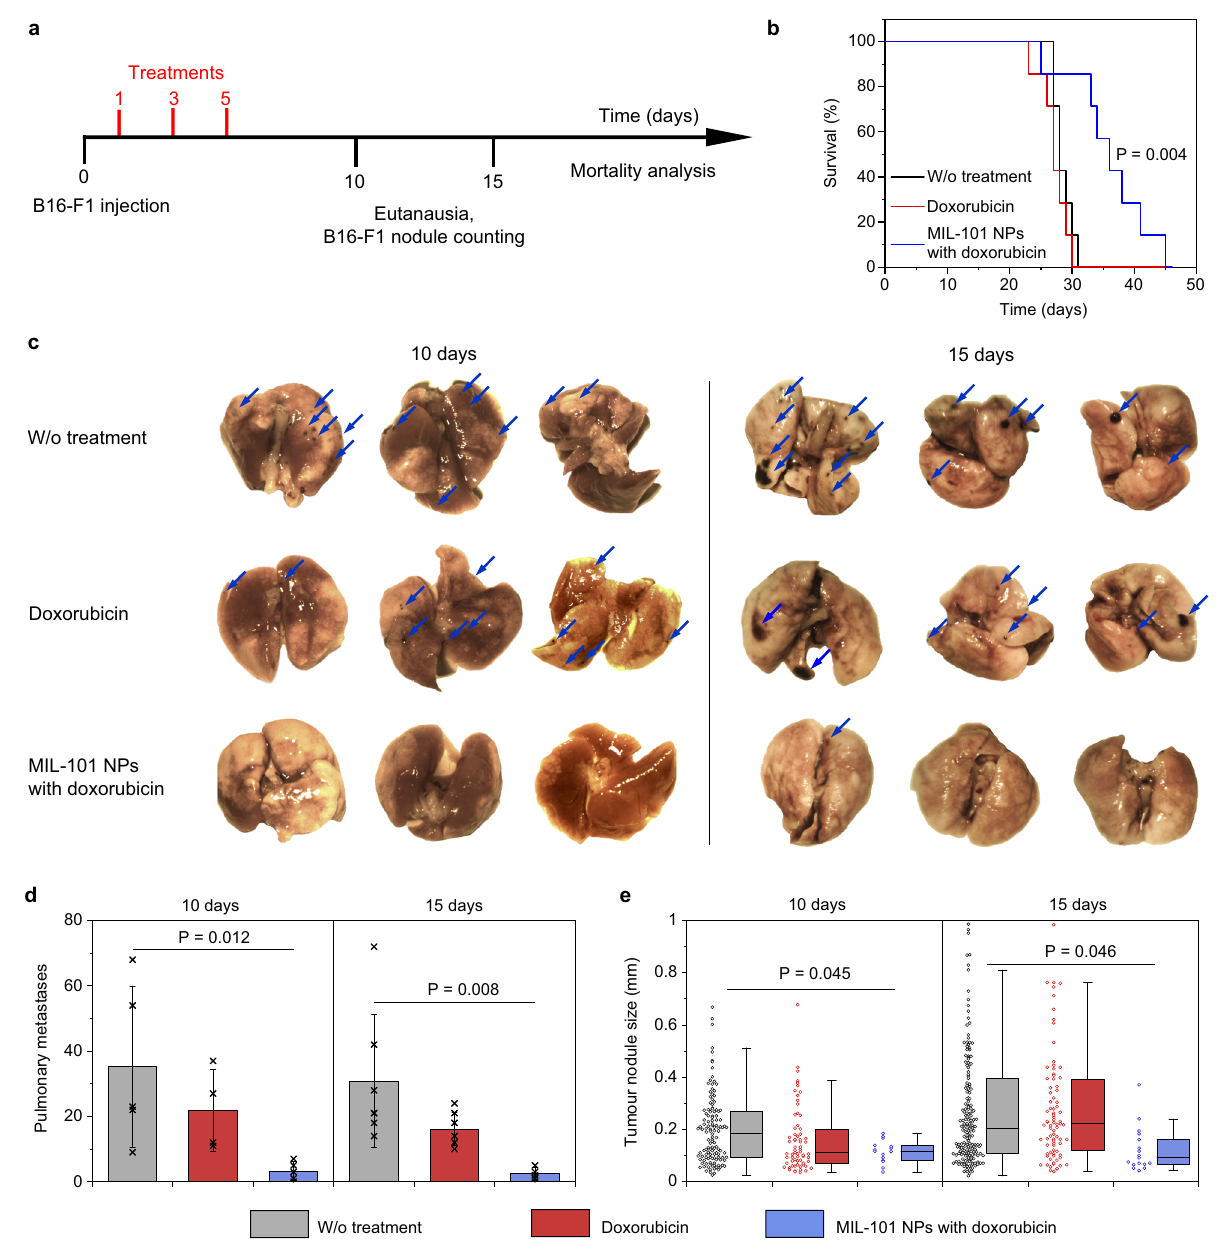
Fig. 6 | Doxorubicin-loaded MIL-101 NPs effectively treat melanoma in early- stage pulmonary metastasis model. a Treatment schedule. b Kaplan-Meier sur- vival curves of mice after the treatment with PBS (black), doxorubicin (red) or doxorubicin-loaded MIL-101 NPs (blue). n =7 mice per group. Two-sided log-rank testwasusedforstatisticalanalysis. c Representative imagesof lungs,collectedon Day 10 (left) or 15 (right) post cancer cell administration. Mice were treated with PBS (top line), doxorubicin (middle line) or doxorubicin-loaded MIL-101 NPs (bot- tom line). Blue arrows point to the melanoma metastases. n =3 mice per group. d Quanti fi cationofthesurfacemetastasesintheharvestedlungsonDay10andDay 15 after the treatment with PBS (grey), doxorubicin (red) or doxorubicin-loaded MIL-101NPs(blue).Dataarepresentedasmeanvalues±SD. e Analysisofthenodule